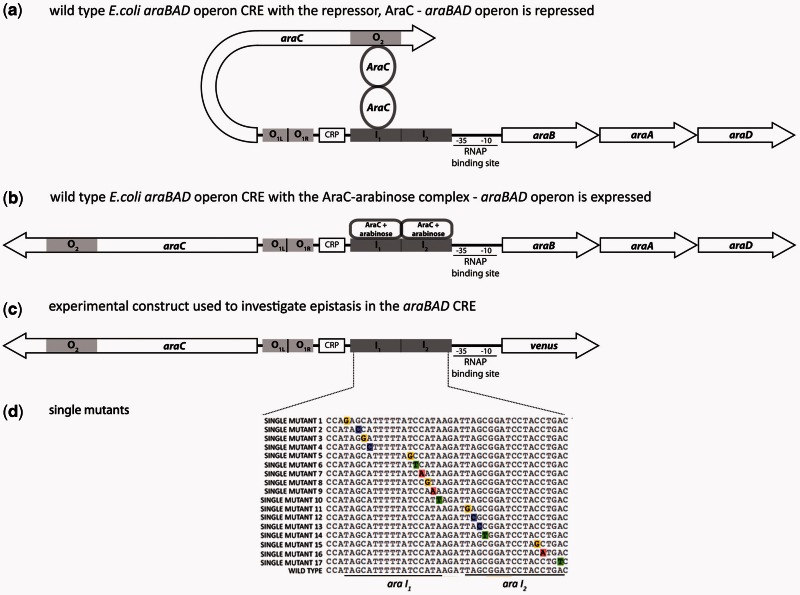
Structure of araBAD operon and regulatory function of AraC. The cis-regulatory region of the araBAD operon consists of two proximal AraC operators, araI1 and araI2, two intermediate operators, araO1L and araO1R, and the distal operator, araO2. The cis-regulatory element also contains a CRP binding site. (a) In the absence of arabinose, AraC preferentially binds to operators araI1 and araO2, forming a DNA loop and repressing transcription. (b) In the presence of arabinose, the AraC–arabinose complex binds to araI1 and araI2 operator sites, actively recruiting RNA polymerase and promoting transcription. (c) The structure of the experimental synthetic construct in which the araBAD operon has been replaced by a fluorescence reporter gene, venus-yfp. (d) We introduced point mutations in all base pairs in araI1 and araI2 operators for which it was previously determined through gel shift assays that any substitution decreased AraC binding by at least 10-fold (Niland et al. 1996).